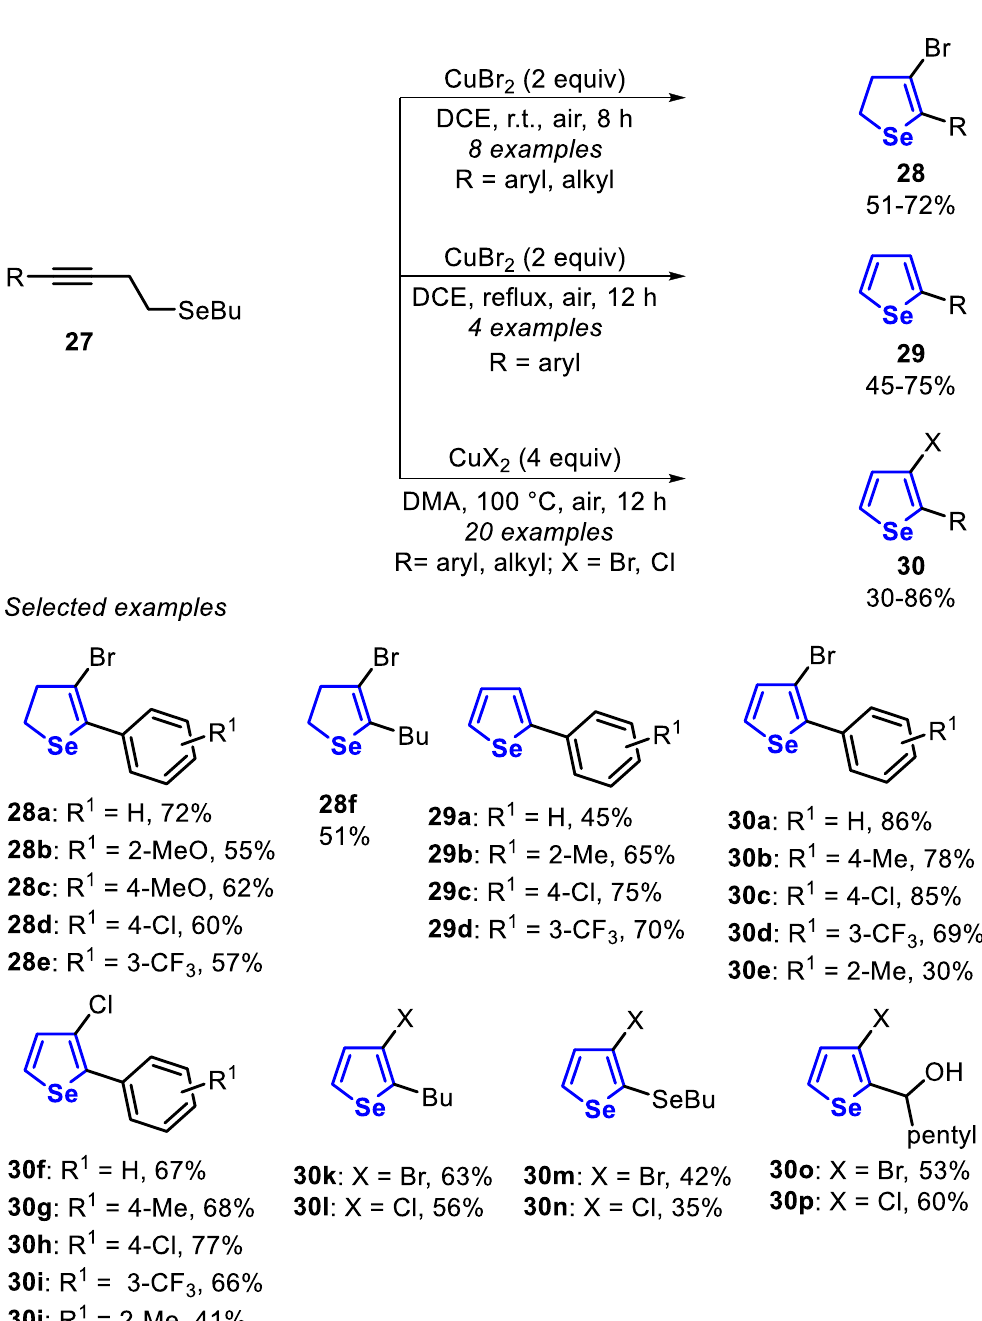
Scheme 23. Scope of the Cu(II) / halide-mediated cyclization of homopropargyl